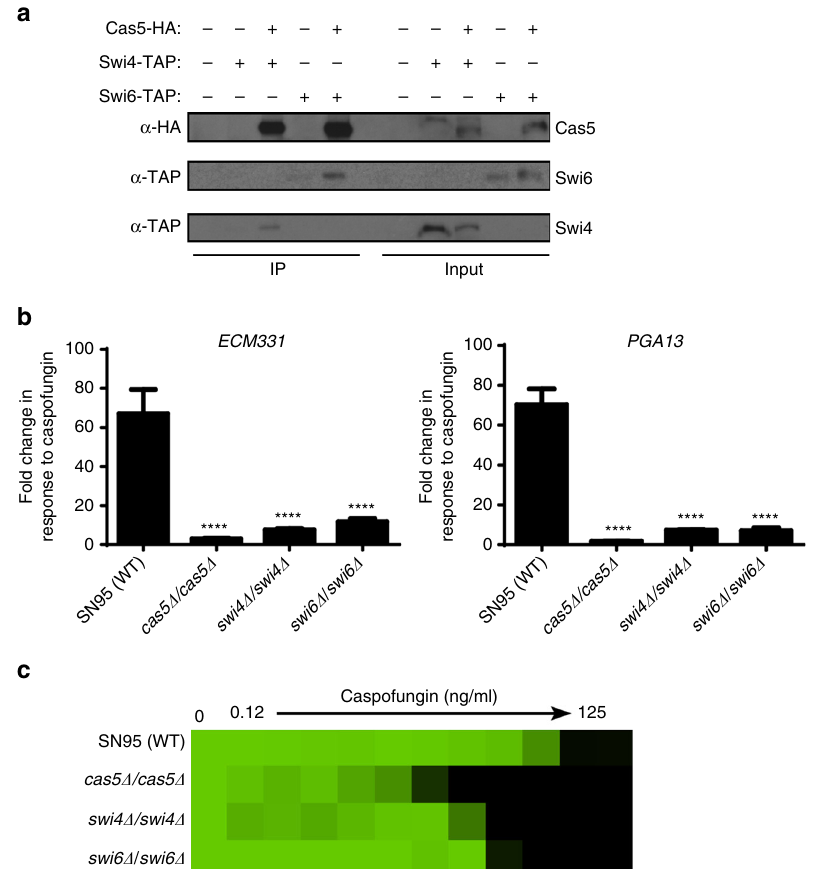
Fig. 8 Cas5 regulates caspofungin tolerance in part through the interaction with components of the SBF complex, Swi4 and Swi6. a Swi4 and Swi6 co-purify with Cas5. C terminally HA-tagged Cas5 was immunoprecipitated with α -HA beads. Swi4 and Swi6 co-puri fi cation was monitored by western blot and detected with an α -TAP antibody. Cas5 pull down was con fi rmed by detection with an α -HA antibody. Input samples con fi rm the expression of tagged proteins. Full blots are shown in Supplementary Fig. 6. b Cas5, Swi4, and Swi6 are required for the upregulation of caspofungin-responsive genes. The transcript levels of ECM331 and PGA13 was monitored by qRT-PCR and normalized to GPD1 . Plotted are the fold-changes in transcript levels in the presence of caspofungin relative to untreated. Error bars represent standard deviation (s.d.) from the mean of triplicate samples. The fold change in gene expression for each mutant strain was compared to the wildtype using one-way ANOVA in GraphPad Prism (**** P < 0.0001). c Swi4 and Swi6 regulate cell wall stress response. Caspofungin susceptibility assays were conducted in YPD medium. Growth was measured by absorbance at 600 nm after 48 h at 30 °C. Optical densities were averaged for duplicate measurements. Data was quantitatively displayed with color using Treeview (see color bar in Fig.